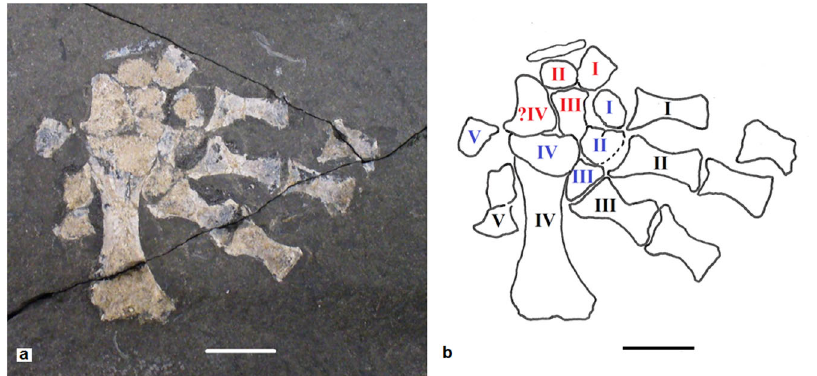
Fig. 3 Termonerpeton makrydactylus gen. et sp. nov partial pes, attributed specimen NMS G.1992.22.1. a Specimen photograph, b with centralia, distal tarsals, and metatarsals indicated by red, blue, and black Roman numerals, respectively. Scale bars 10 mm.